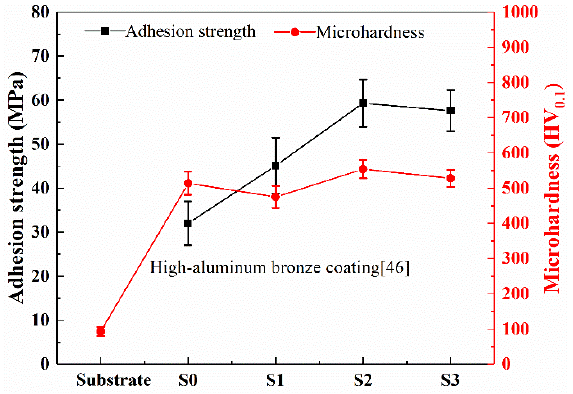
Figure 9. Bonding strength and microhardness of the coatings.